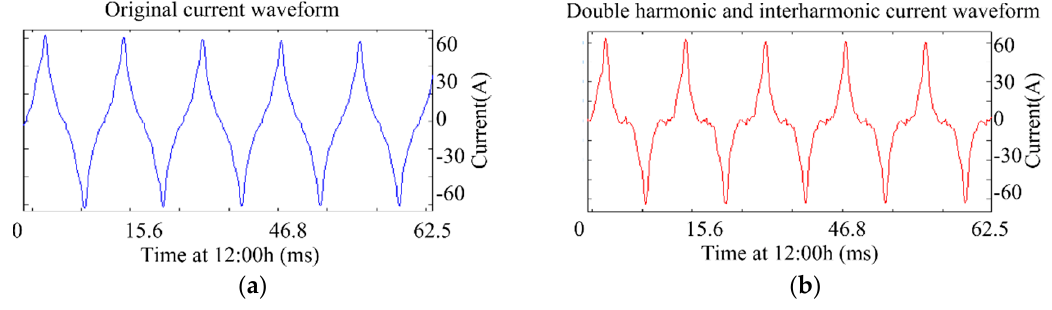
Figure 14. Current signals: ( a ) the original current waveform; and ( b ) the simulated double harmonic